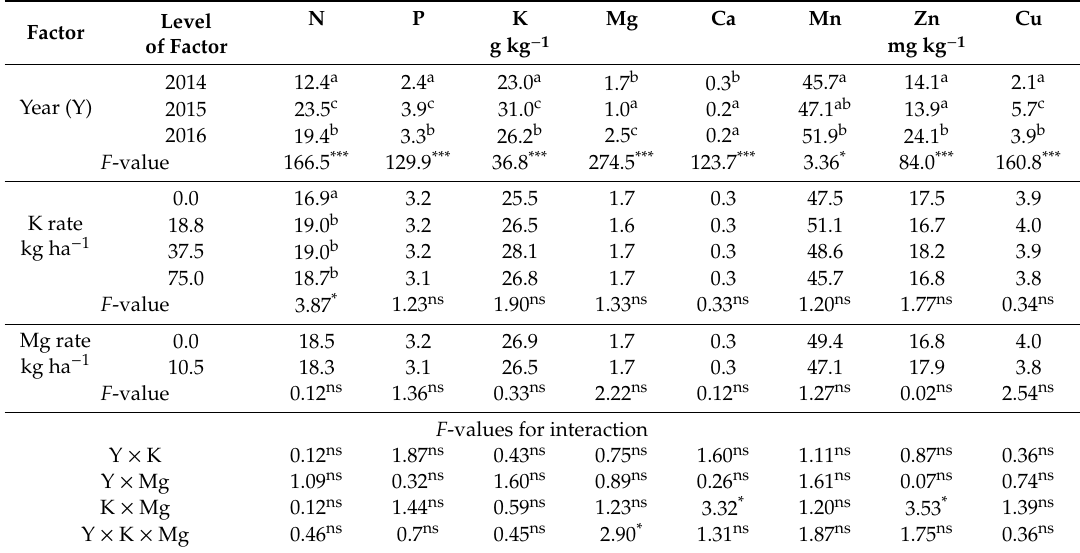
Table 3. Nutrient content in leaves of spelt wheat at heading (BBCH